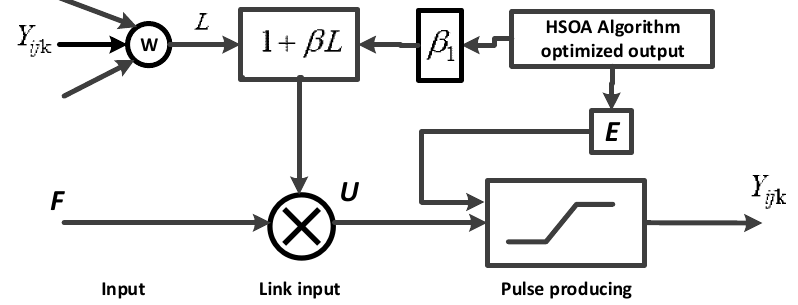
Figure 5. 3DPCNN-HSOA model.